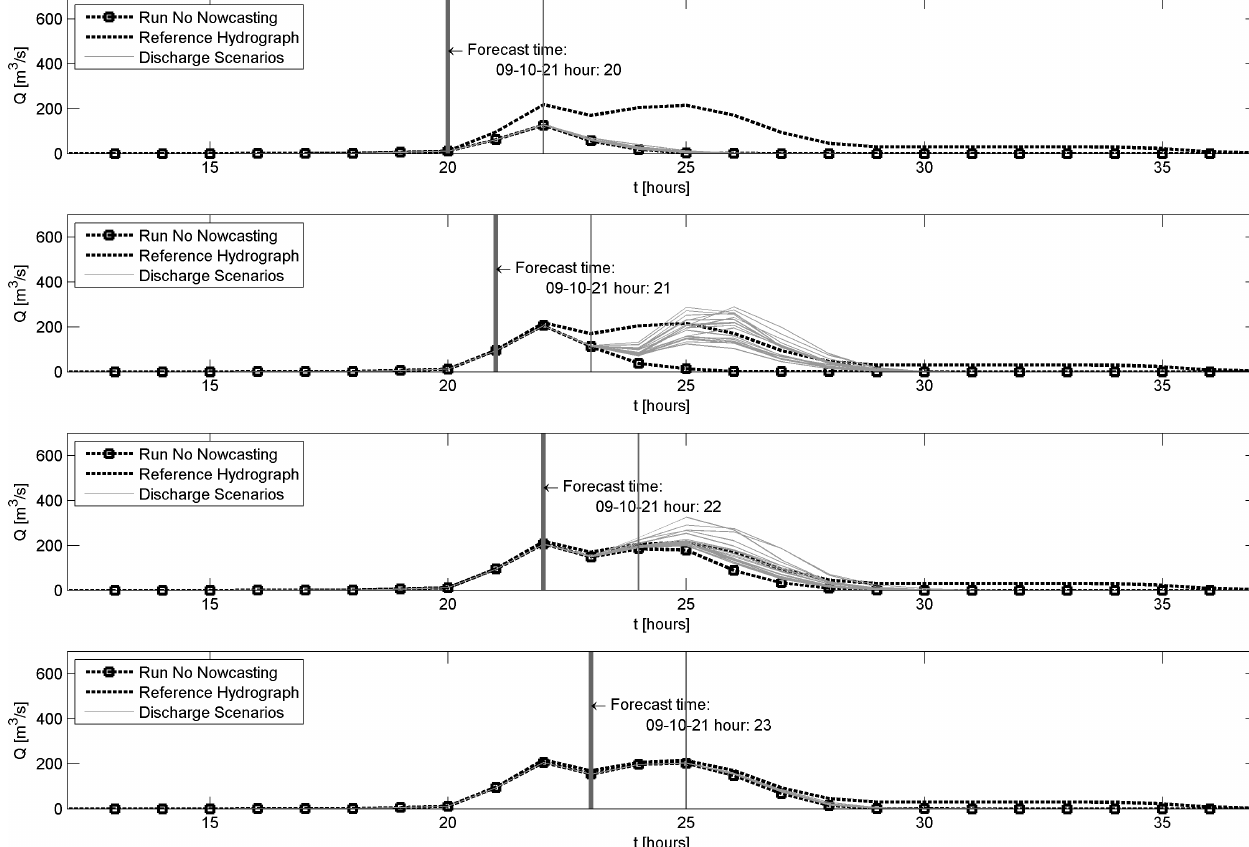
Fig. 4. Results of hydrological nowcasting framework for the Entella Basin closed at Panesi (Area = 364km 2 ) . The event on 21 Oct 2009 is shown. The thick grey vertical line represents the time of the last available observed field for each nowcasted scenario. The thin grey vertical line represents the end of nowcasting. The Run No Nowcasting is the discharge obtained feeding the rainfall-runoff model with observed rainfall